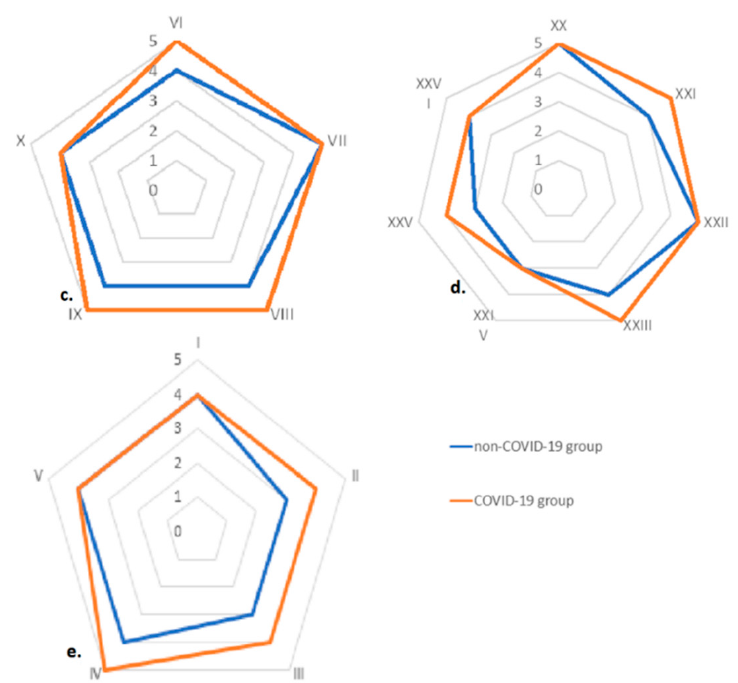
Figure 1. Comparison of the dimensions of responsiveness ( a ), assurance ( b ), reliability ( c ), empathy ( d ) and tangibility ( e ) between the COVID-19 and non-COVID-19 group.